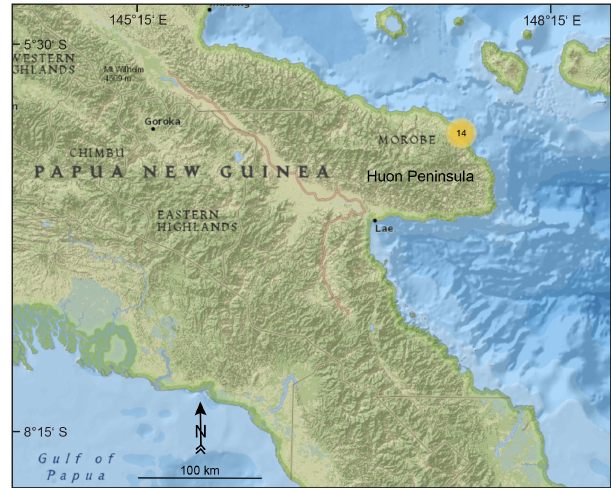
Figure 11. Map showing study sites on the Huon Peninsula, Papua New Guinea, considered in this article (orange circle). Basemap: “National Geographic Map”, with data from National Geographic, Esri, Garmin, HERE, UNEP-WCMC, USGS, NASA, ESA, METI, NRCAN, GEBCO, NOAA and INCREMENT P